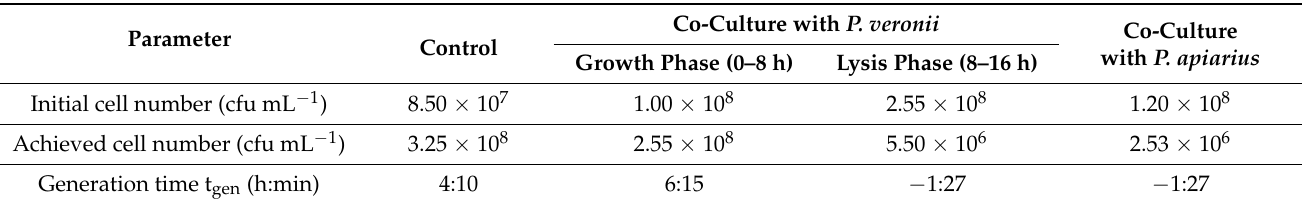
Table 4. Generation times of A. citreus in the control culture, during growth and lysis phase in the co-culture with P. veronii and in co-culture with P. apiarius . Co-Culture with P. veronii Co-Culture Parameter Control with P. apiarius Growth Phase (0–8 h) Lysis Phase (8–16